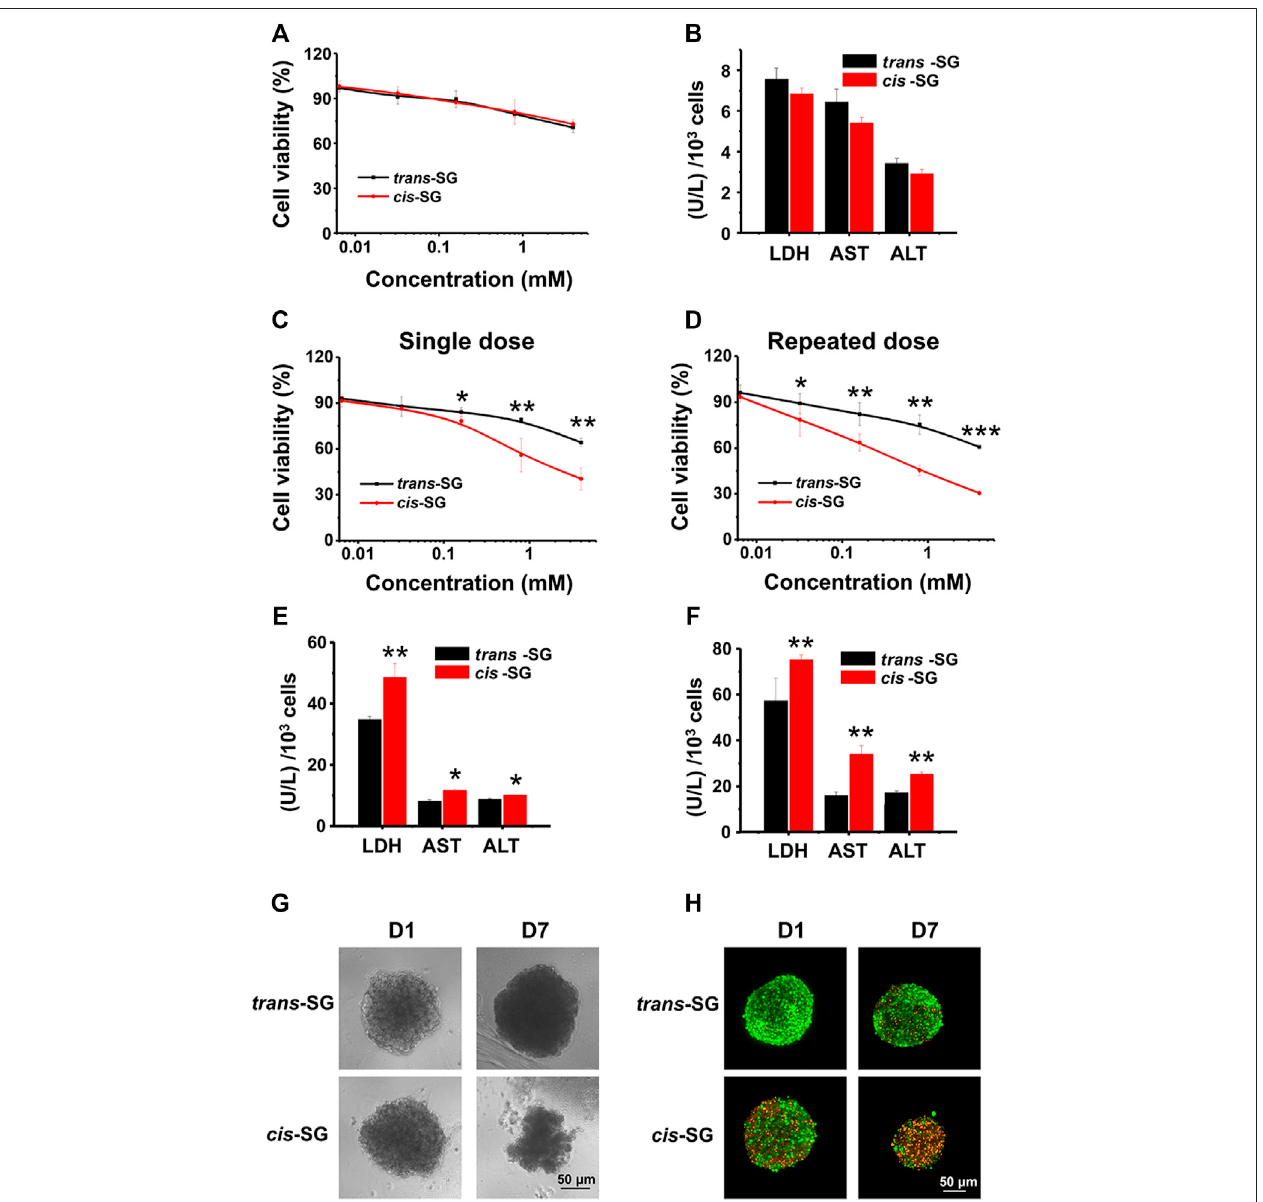
FIGURE 3 | Organoid-based in vitro evaluation differentiated hepatotoxicity of cis-SG and trans-SG isomers. (A,B) Cell viability analysis (A) and biochemistry test (LDH, AST, and ALT) (B) on 2D cultured HepaRG cells showing no difference between the two isomers after 24 h of drug exposure. (C,D) Cell viability analysis of trans- SG and cis-SG on 3D cultured HepaRG organoids with single-dose (C) or repeated-dose (D) treatment. (E,F) The LDH, AST, and ALT levels of 3D cultured HepaRG organoids after being treated with trans-SG and cis-SG in single-dose (E) or repeated-dose (F) . (G) The morphological images of HepaRG organoids after being treatedwith trans-SG and cis-SG for1or7 days. (H) The fl uorescent imagesofHepaRGorganoids afterbeingtreatedwith trans-SG and cis-SG for1or7 days withlive (green)/dead (orange) staining. Scale bar = 50 μ m. Values are expressed as mean ± SD. * p < 0.05; ** p < 0.01; *** p < 0.001.